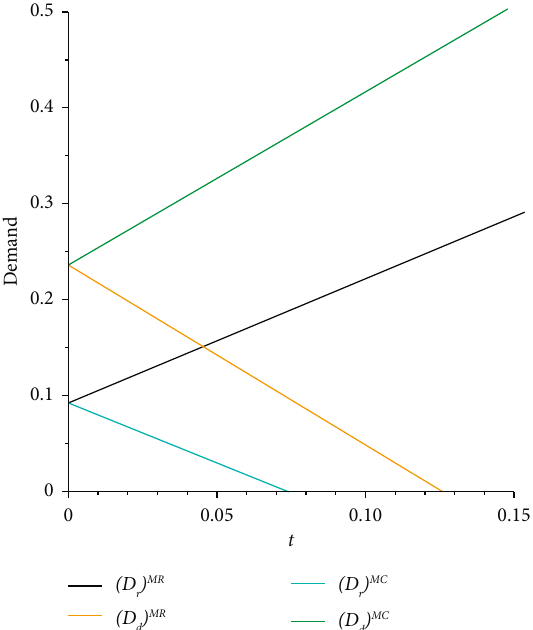
Figure 9: Effect of t on optimal